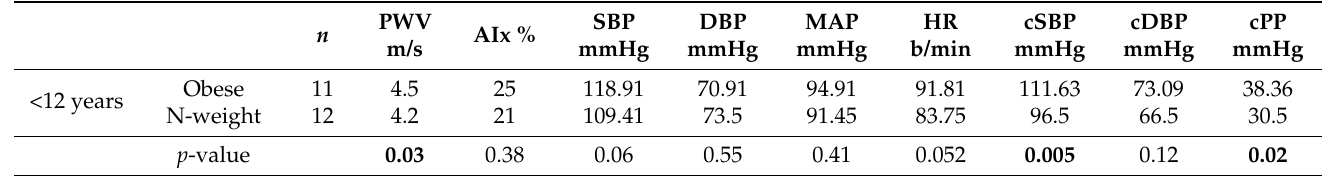
Table 7. PWA parameters comparison in subjects <12 years old.